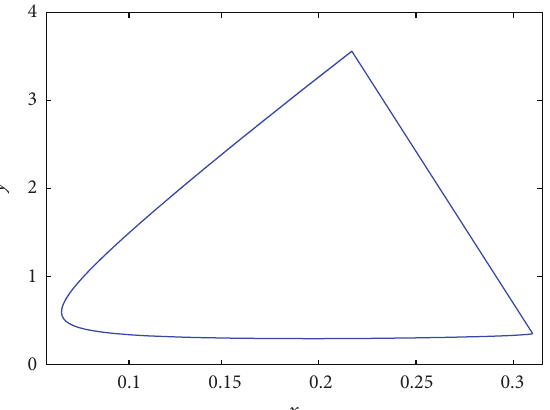
Figure 10: Plot of the positive periodic solution when ℎ 1 < (1 − < 𝑥 ∗ < ℎ ℎ = 0.05 , ℎ = 0.31 , 𝛼 = 0.3 , 𝛽 = 0.2 , and 𝛼)ℎ 2 2 with 1 2 = 3.28 𝜏 2